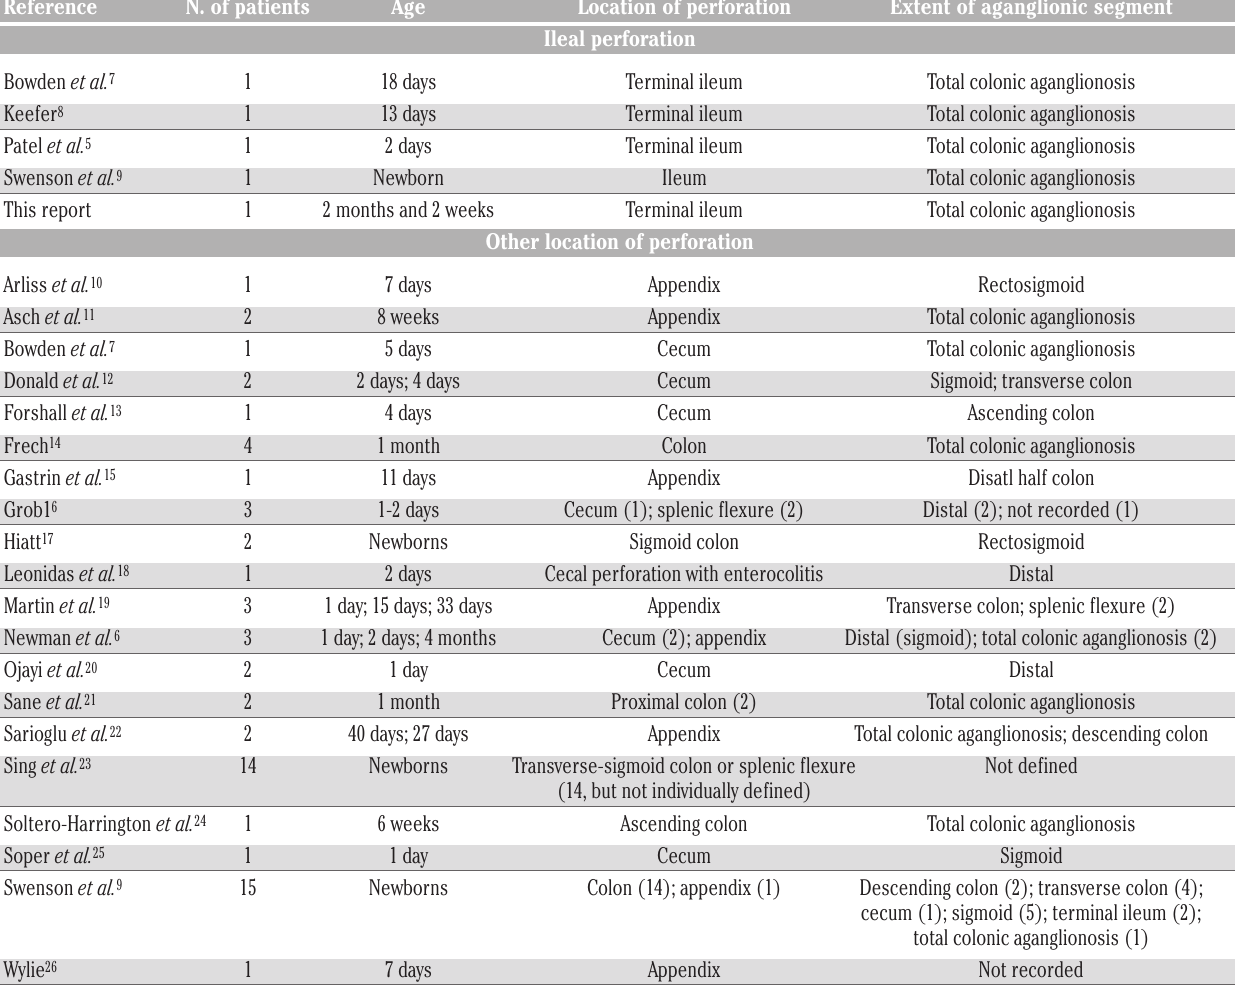
Table 1. Literature survey of patients with Hirschsprung’s disease presenting with ileal or other location of perforation as initial pres- entation